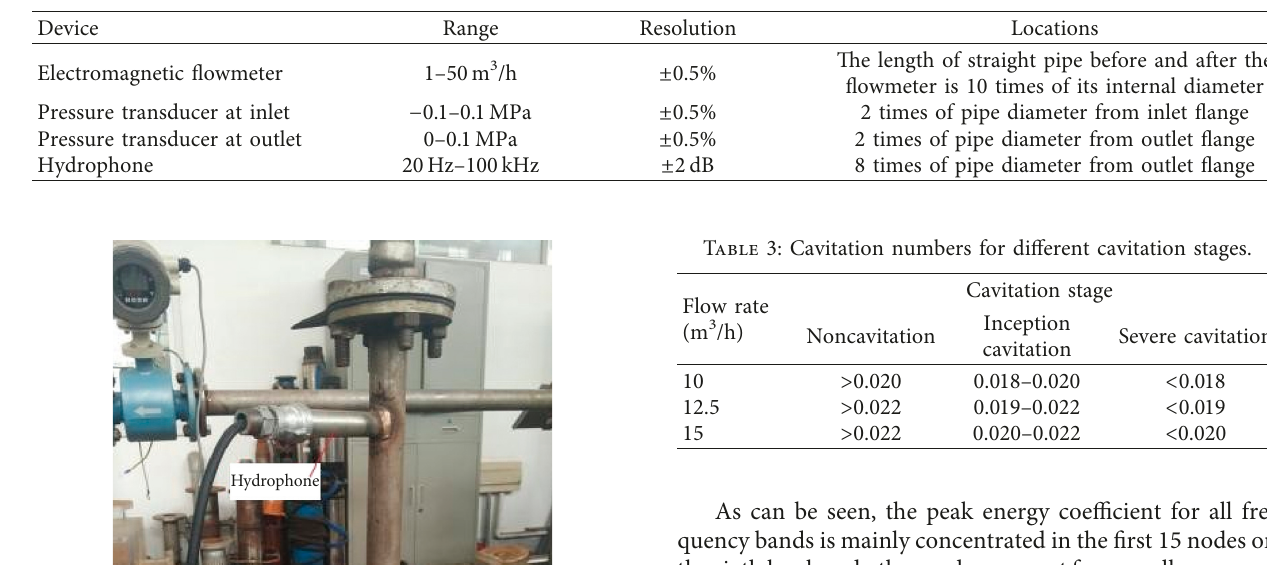
Table 2: Instruments in the measuring system.